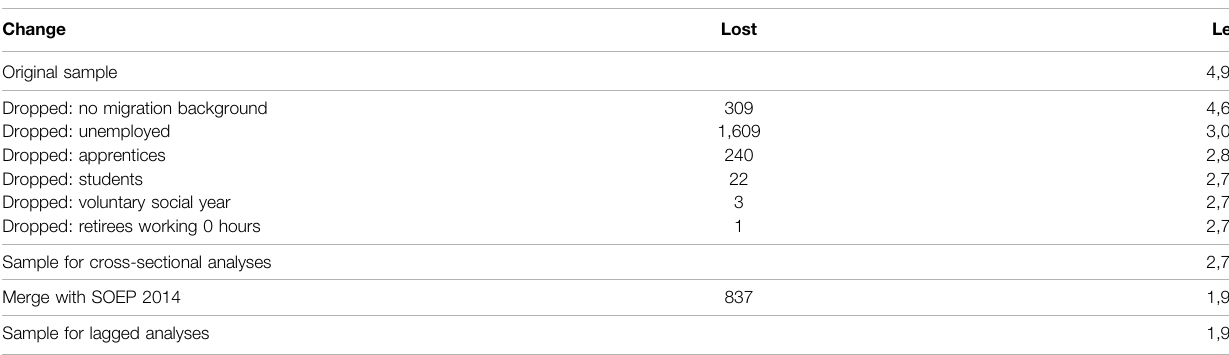
TABLE A1 | Sample development.